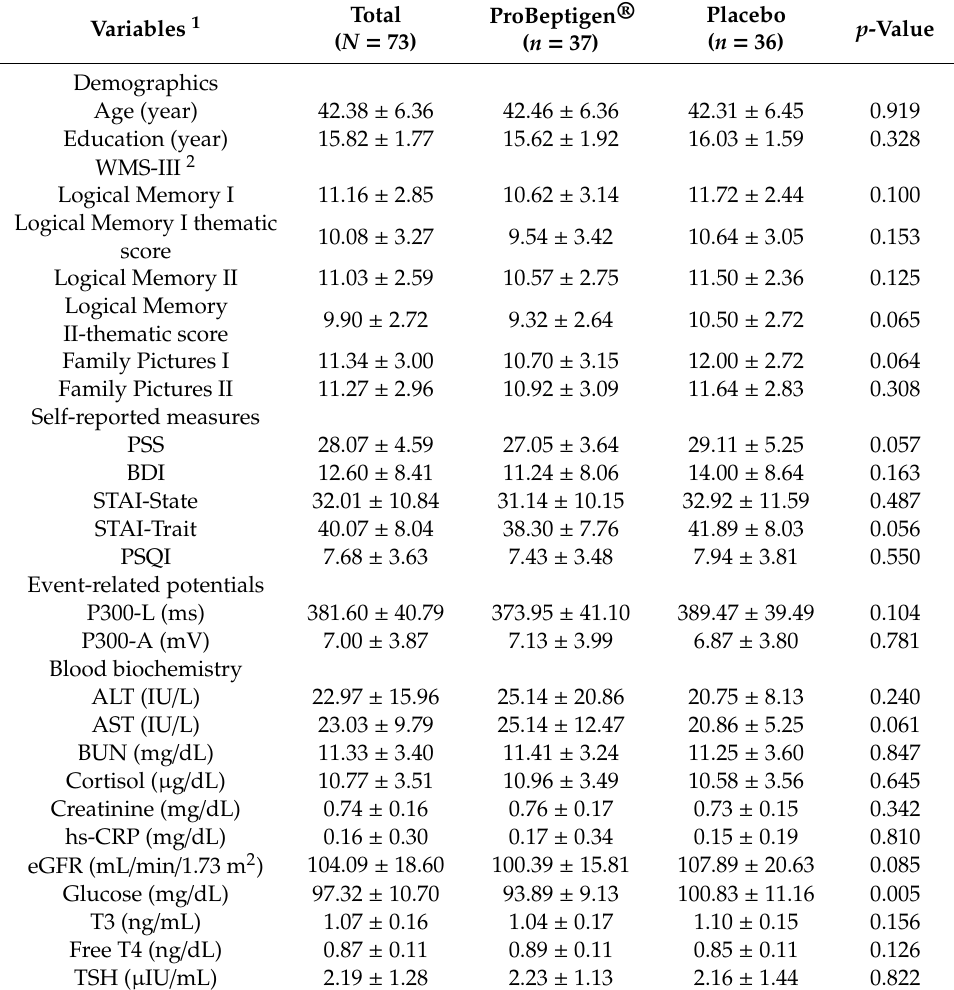
Table 1. Baseline (visit 2) information of participants who completed the whole